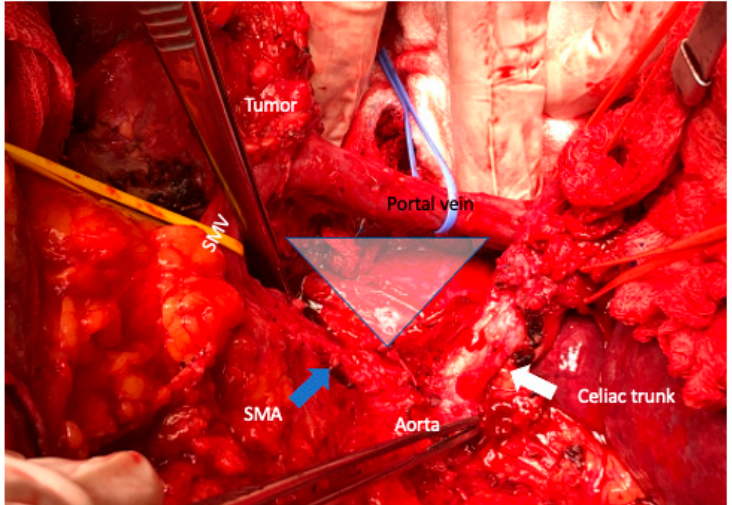
Figure 5. The TRIANGLE operation (blue triangle zone) is a proper approach to achieve a complete and radical removal of the tumor and associated lymphatic or perineural extension along a region defined anatomically by the origins of the celiac trunk (white arrow), the superior mesenteric artery (SMA) (blue arrow), the portal vein (anteriorly), and superior mesenteric vein (SMV).